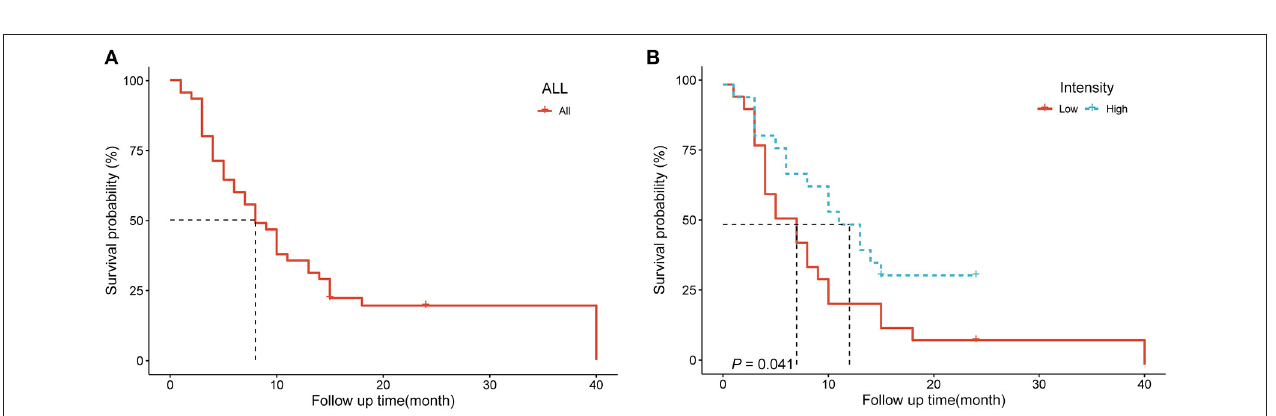
FIGURE 3 | (A) Survival analysis curves for 45 patients with spinal metastases (B) Survival analysis of patients in different intensity